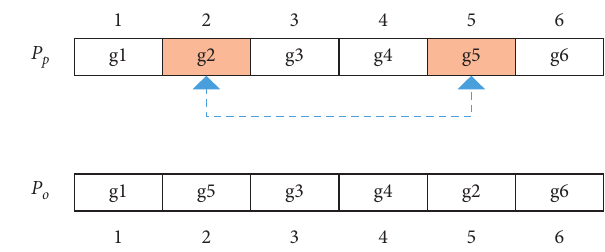
Figure 4: Schematic diagram of inverted mutation. Figure